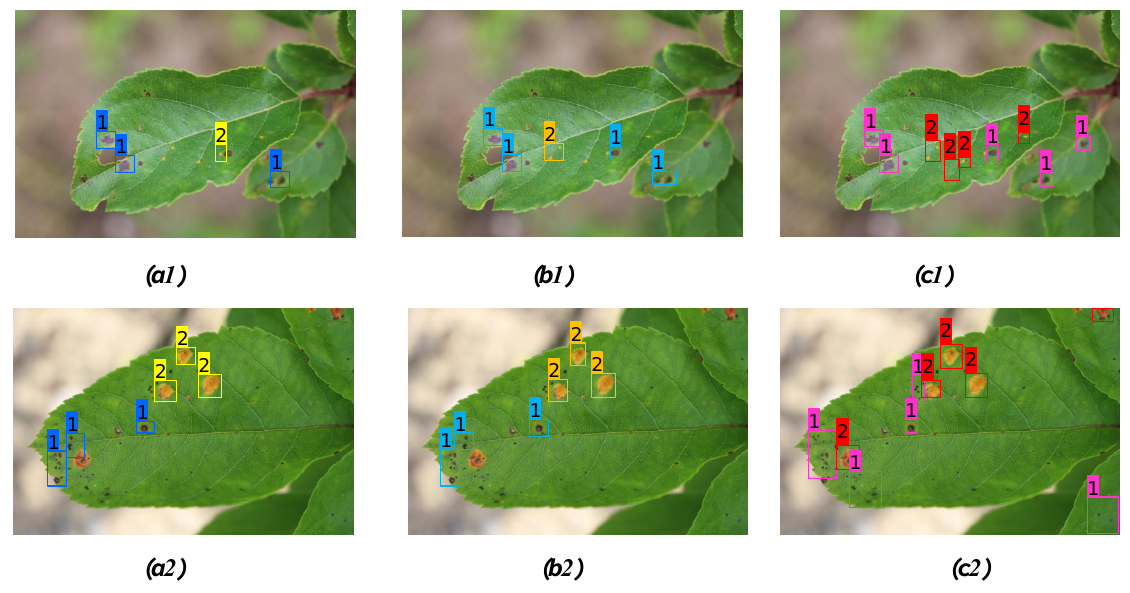
Figure 10. Comparison of detection result for both apple scab and rust on two distinct apple leaves from three